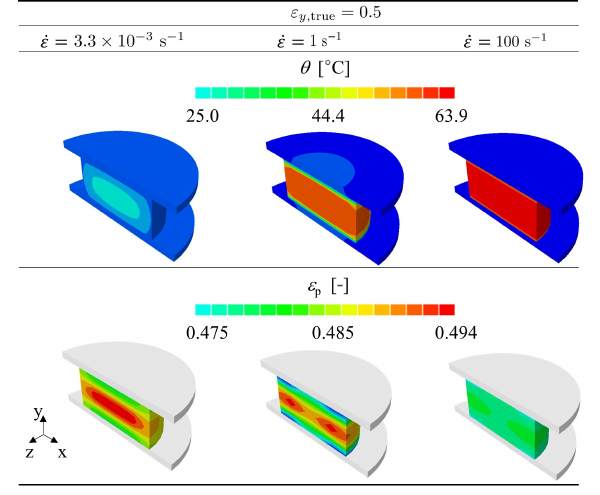
Figure 12. Predicted temperature distribution within the PR520 cylinder specimen at different strain